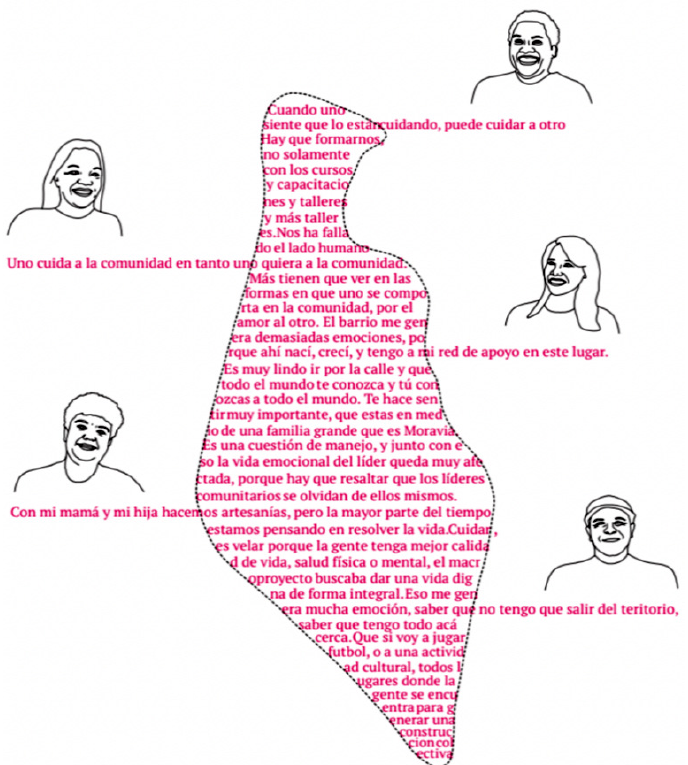
Figure 4. Moravia’s map weaved with community leaders’ stories. Source: Drawn by Care Team cohort 2020–2021 for Atlas of Living